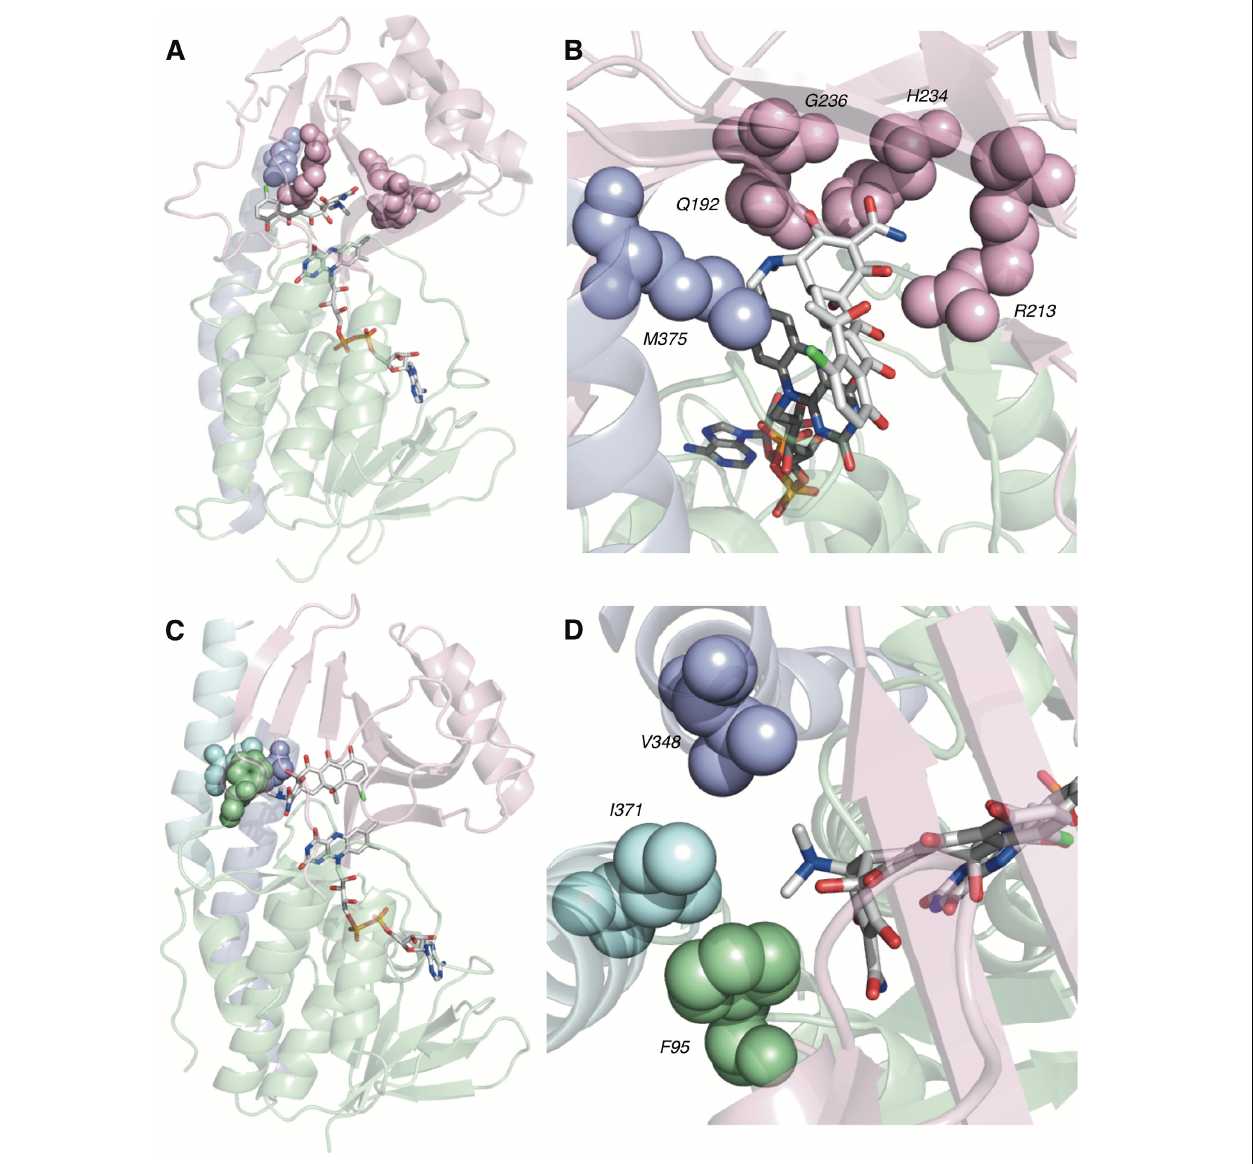
FIGURE 6 | Recognition elements of CTc A-ring for each experimentally observed substrate-binding mode. (A) X-ray structure of CTc bound to TetX in Mode I D , A (PDB ID: 2y6r). (B) Expanded X-ray structure of CTc bound to TetX in Mode I D , A with interacting structural residues highlighted and labeled (PDB ID: 2y6r). (C) X-ray structure of CTc bound to Tet50 in Mode II A , D (PDB ID: 5tui). (D) Expanded X-ray structure of CTc bound to Tet50 in Mode II A , D with interacting structural residues highlighted and labeled (PDB ID: 5tui). Images were generated using PyMOL